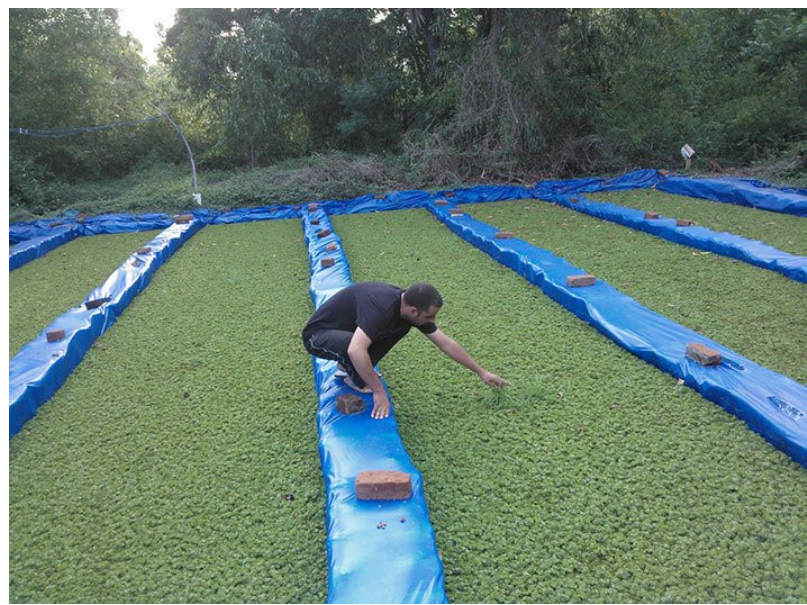
Figure 1. A typical SHEFROL plant treating sewage with duckweed as the main bioagent.